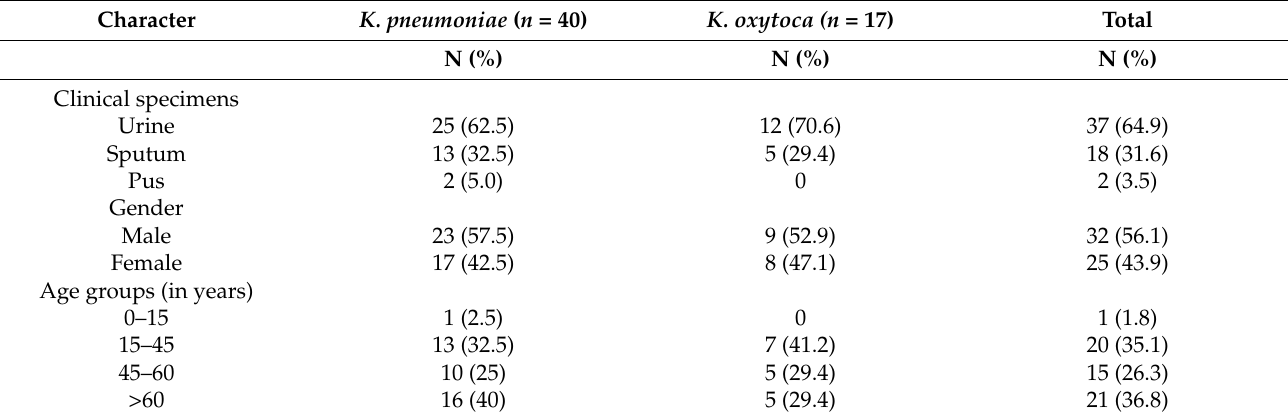
Table 2. Distribution of Klebsiella spp. among patients visiting NPHL ( n =